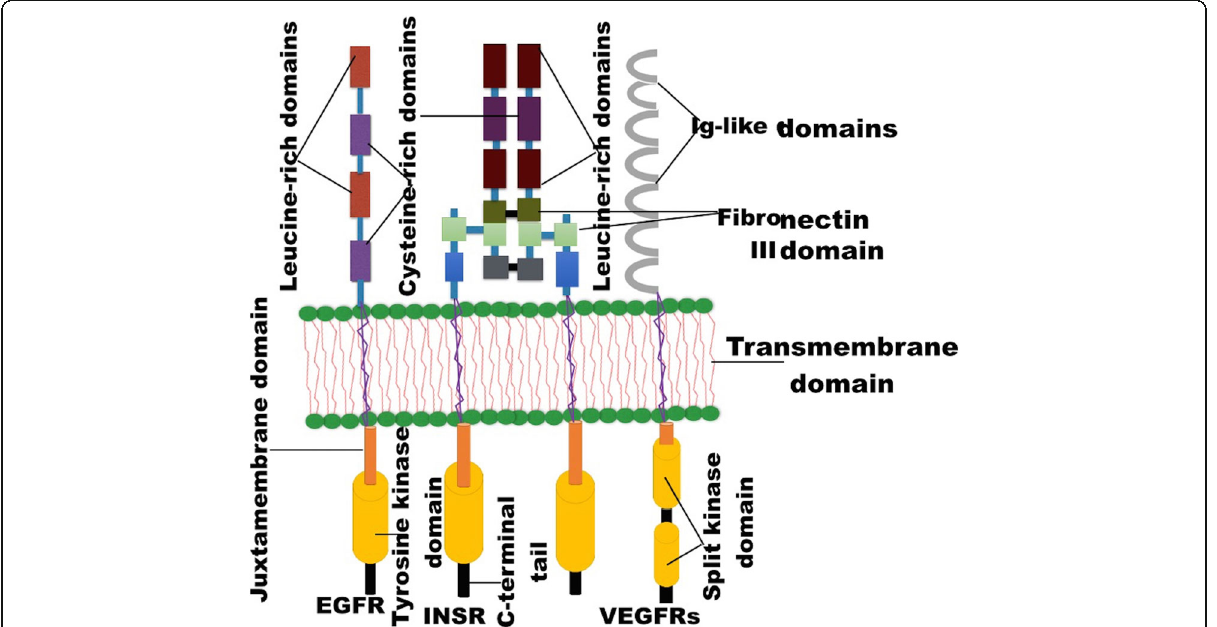
Fig. 1 Structure of RTKs subfamilies. The ligand-binding extracellular domains differ across RTKs subfamilies from immunoglobulin-like (Ig-like) fold type (VEGFRs), fibronectin type III (FnIII) domains (INSR) and Leucine-rich repeat and cysteine-rich domains (EGFR). The Juxtamembrane connect the transmembrane domain to the tyrosine kinase domain (TKD), the TKD contains the catalytic site of the RTKs. The C-terminal domain contains the tyrosine residues, where phosphorylation takes place, it also provide the docking sites for the cytoplasmic signaling molecules to